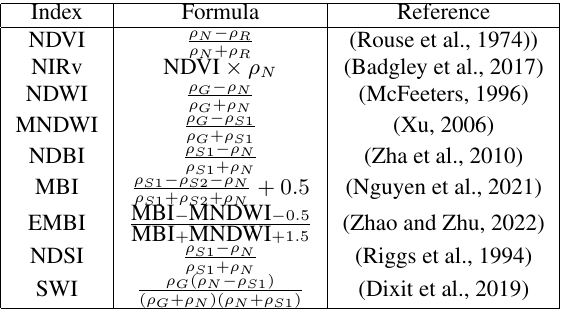
Table 1. Spectral indices used in the Awesome Spectral Indices Visualizer GEE